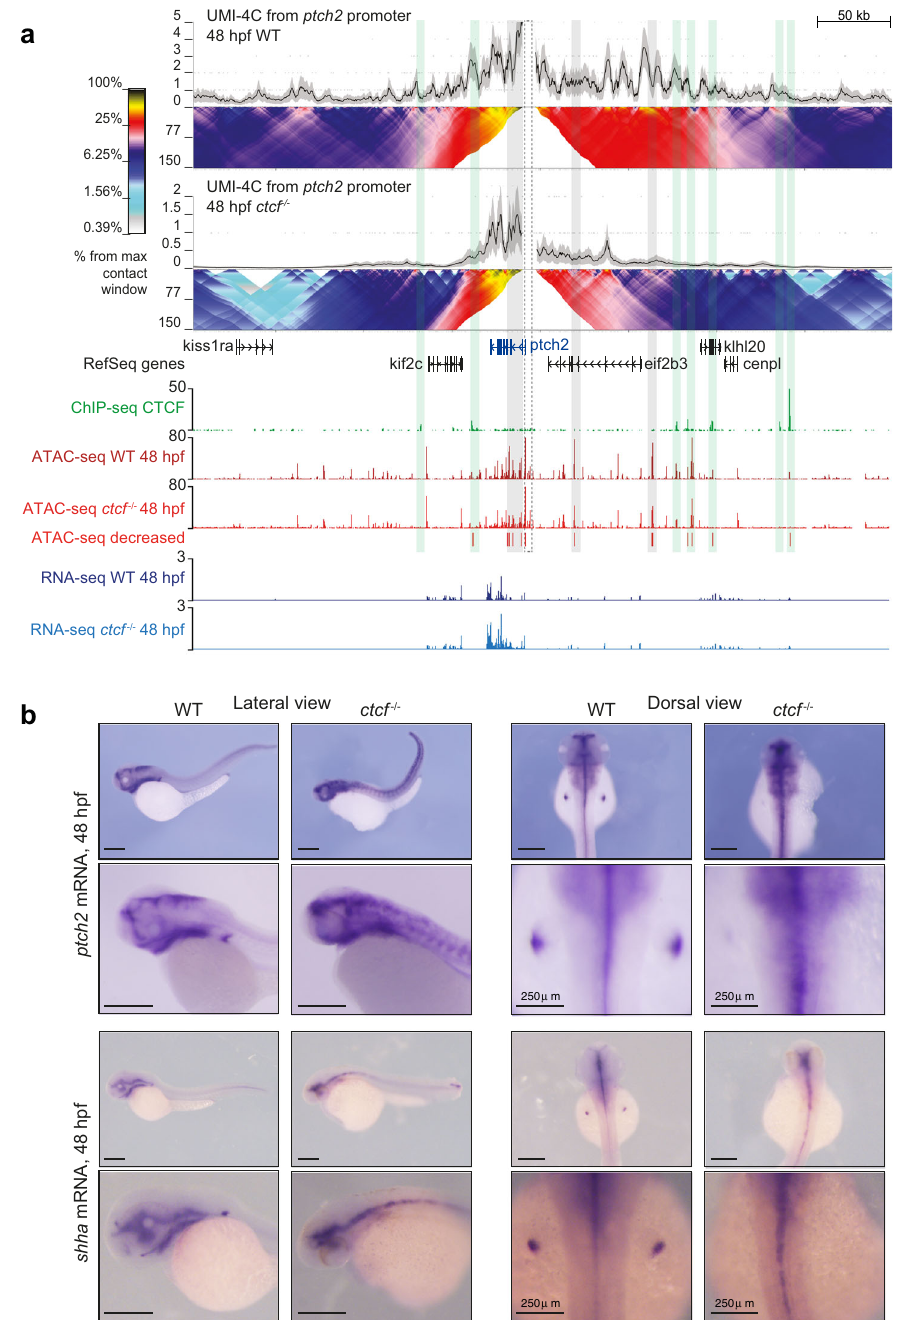
Fig. 6 CTCF is required to sustain the regulatory landscape and expression pattern of the ptch2 gene. a Top, UMI-4C assays in WT and ctcf − / − embryos at 48 hpf using the ptch2 gene promoter as viewpoint. Black lines and gray shadows represent the average normalized UMI counts and their standard deviation, respectively. Domainograms below UMI counts represent contact frequency between pairs of genomic regions. Bottom, tracks with CTCF ChIP-seq, ATAC-seq and RNA-seq at 48 hpf in WT and ctcf − / − embryos, as well as decreased ATAC-seq peaks in ctcf − / − embryos. A dotted-line square represents the restriction fragment containing the ptch2 gene promoter that is used as a viewpoint; green shadows highlight CTCF sites and gray shadows highlight downregulated ATAC-peaks without CTCF binding. Upregulated genes are shown in blue. b Whole-mount in situ hybridizations of the ptch2 and shha genes in WT and ctcf − / − embryos at 48 hpf. Left, lateral view; right, dorsal view. Scale bars represent 500 µ m, unless